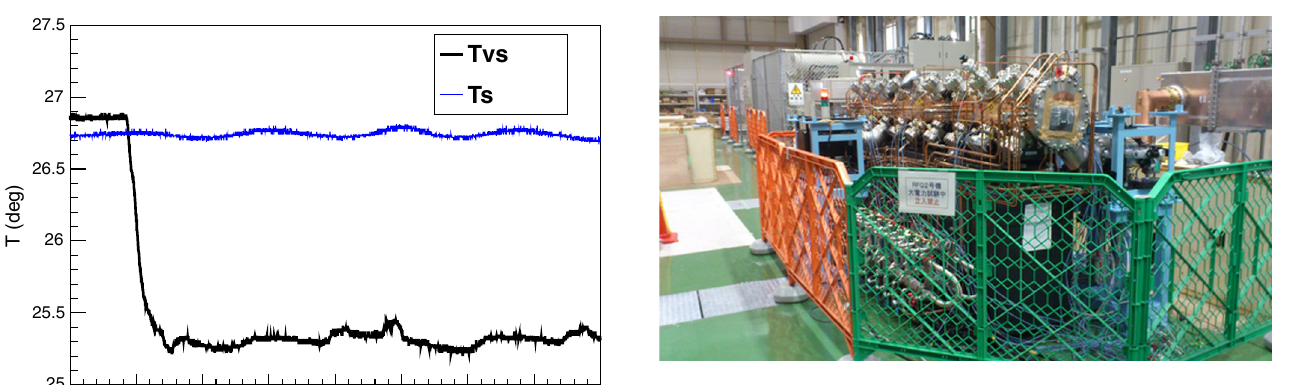
FIG. 6. Photograph of RFQ II under conditioning. This photo- graph shows the view from upstream, and the rf power is fed from the right side of the